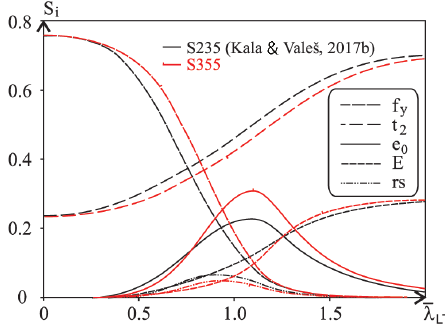
Figure 5. First order Sobol’ sensitivity indices 65×48 mm